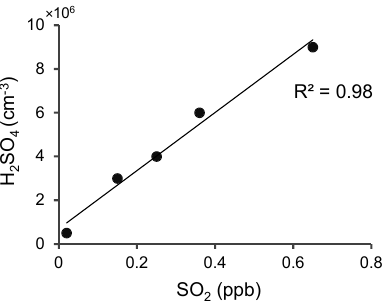
Figure 6. Sulfuric acid concentration as a function of SO 2 concen- tration inside the